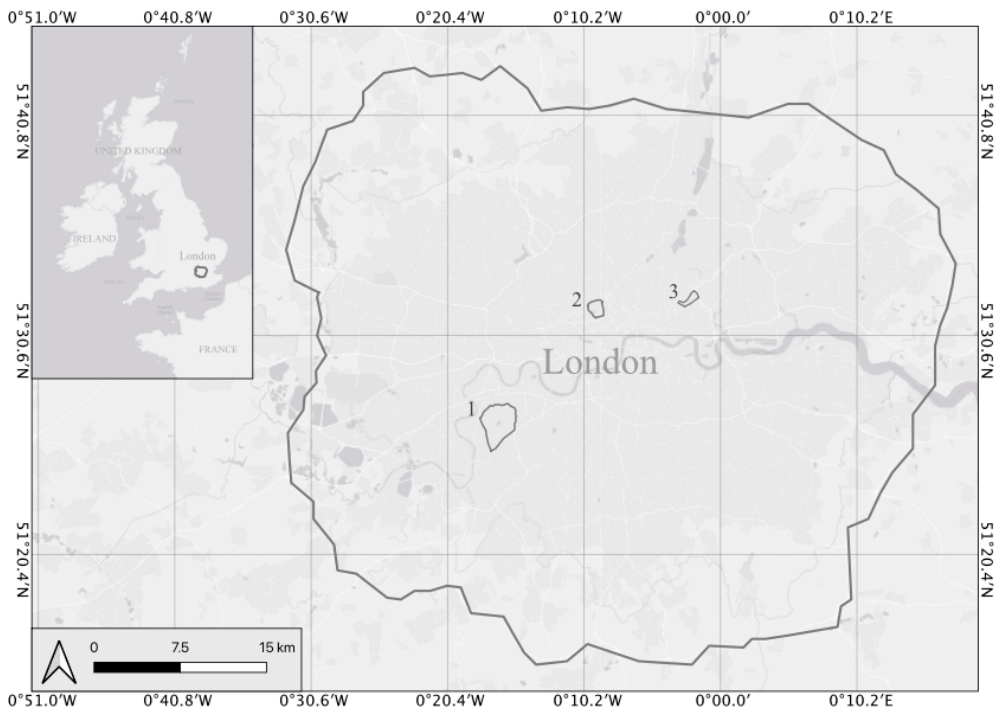
Figure 1. A map of London with the three parks surveyed outlined in bold. (1) Richmond Park, (2) Regent’s Park and (3) Victoria Park. Inset shows the location of London (bold outline) within the UK. Map produced with QGIS v.3.10.